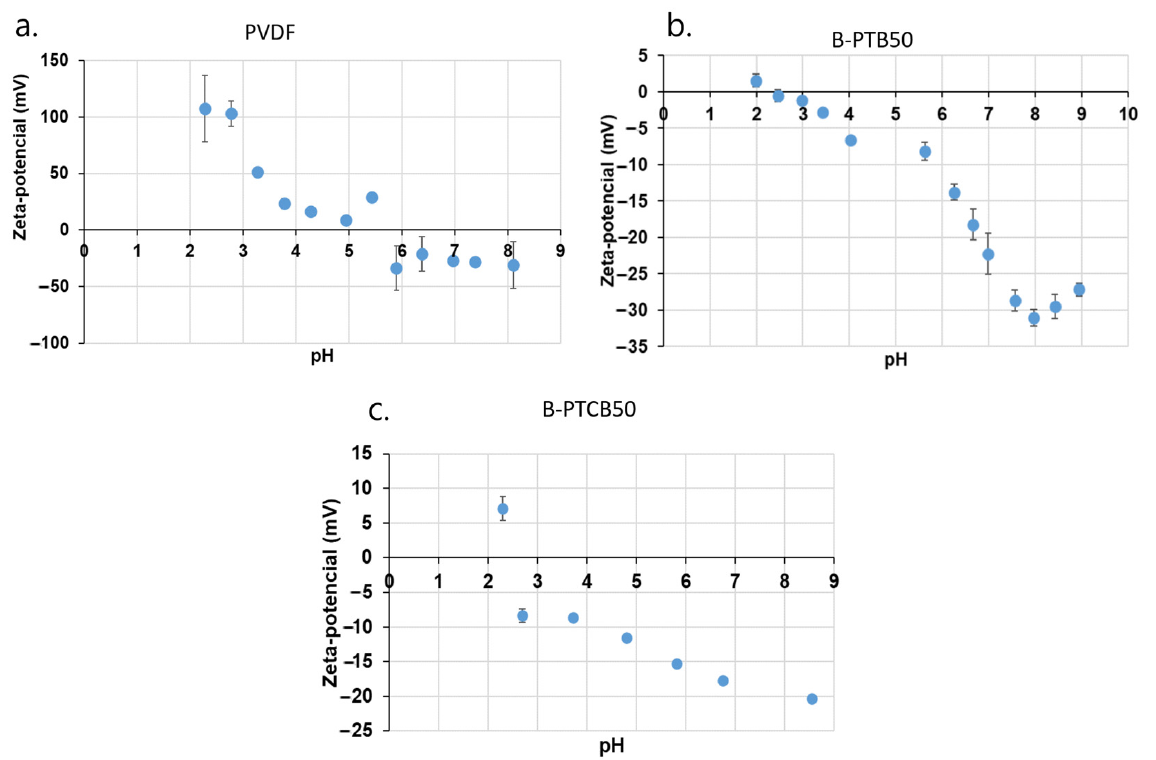
Figure 1. Zeta potentials of unused PVDF, blended PVDF-TiO 2 /BiVO 4 (50–50%) composite (PTB50), and blended PVDF-TiO 2 /CNT/BiVO 4 (48–2–50%) composite (PTCB50) membranes.